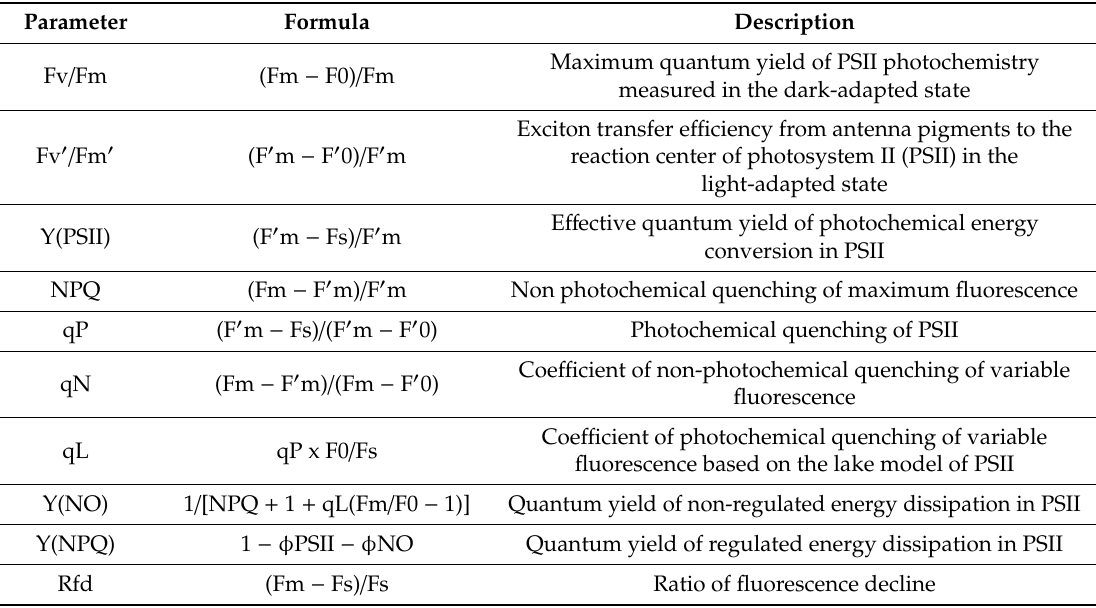
Table 1. The chlorophyll fluorescence parameters used in this